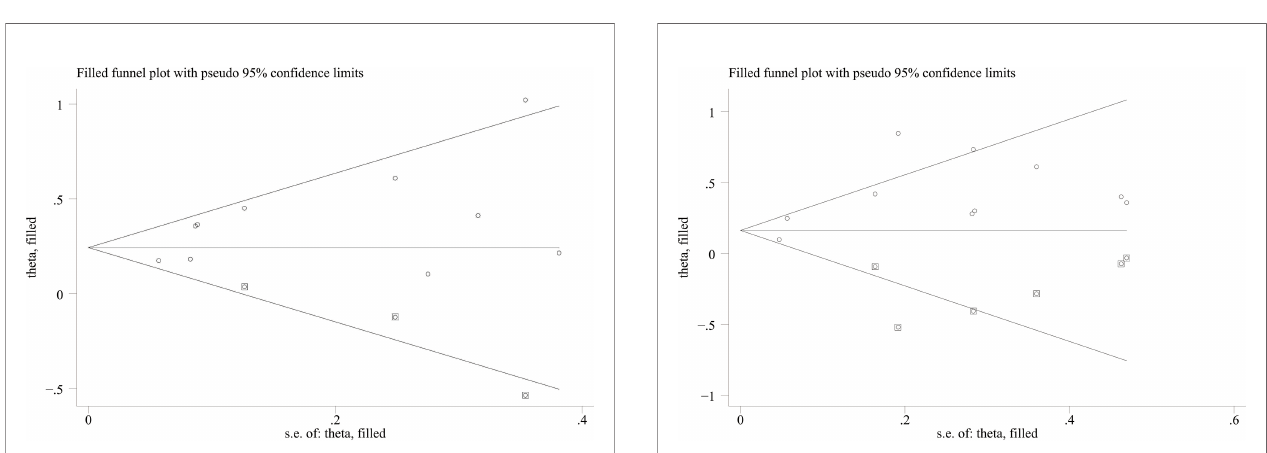
FIGURE 7 | Trimming chart of multivariate analysis outcomes of baseline CRP levels